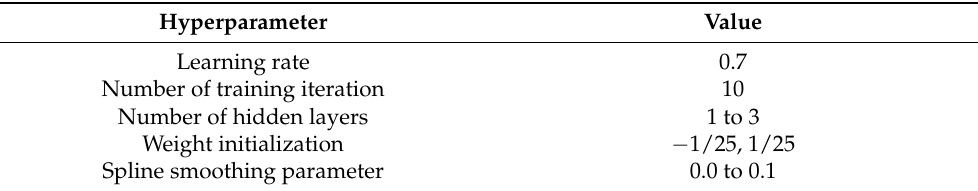
Table 1. Hyperparameter values.